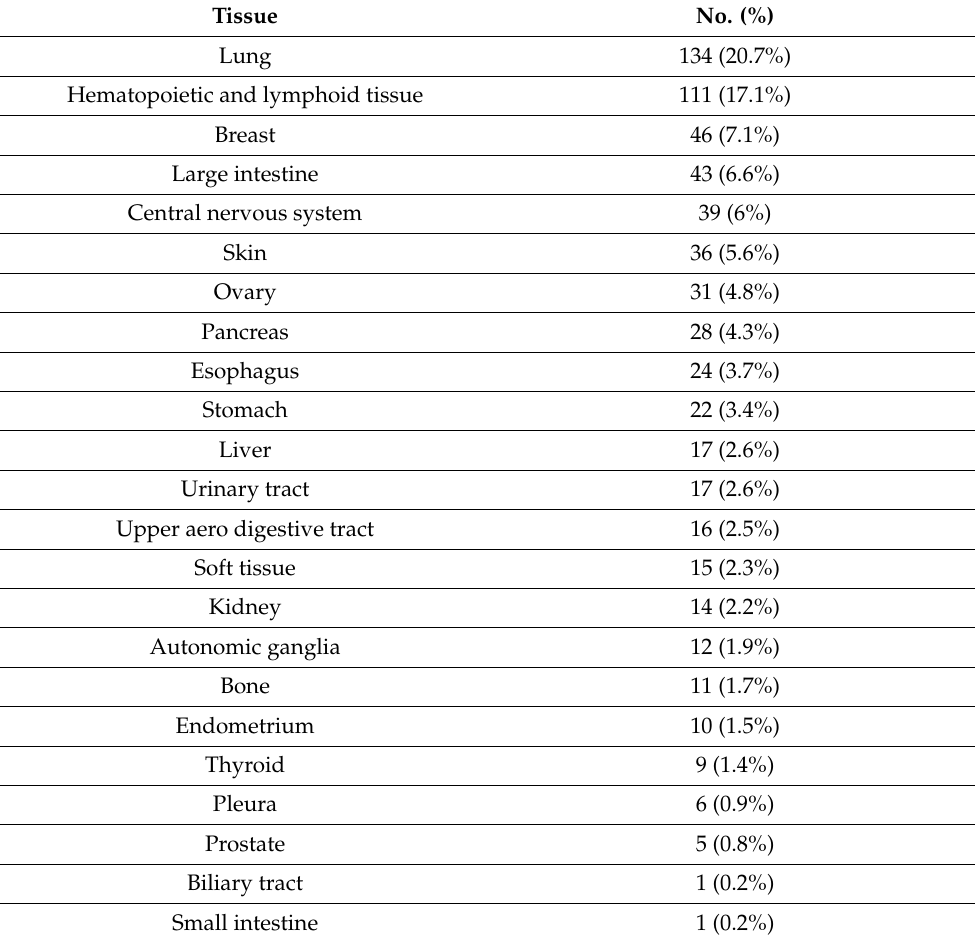
Table 1. Tissues of origin of the 648 cell lines, ordered by frequency.